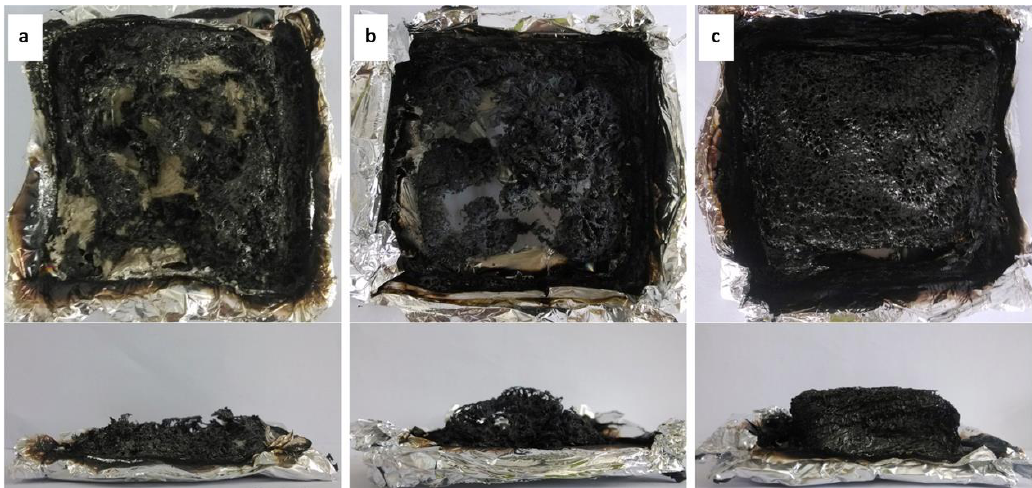
Figure 25. Digital images of cone calorimetry residues of ( a ) pristine epoxy with much broken char, ( b ) 2%-MWNTs/epoxy with local destruction, and ( c ) 2%-MWNTs-PD-10/epoxy with preferable intumescent char. Reprinted with permission from Ref. [181]. Copyright 2016, Elsevier.